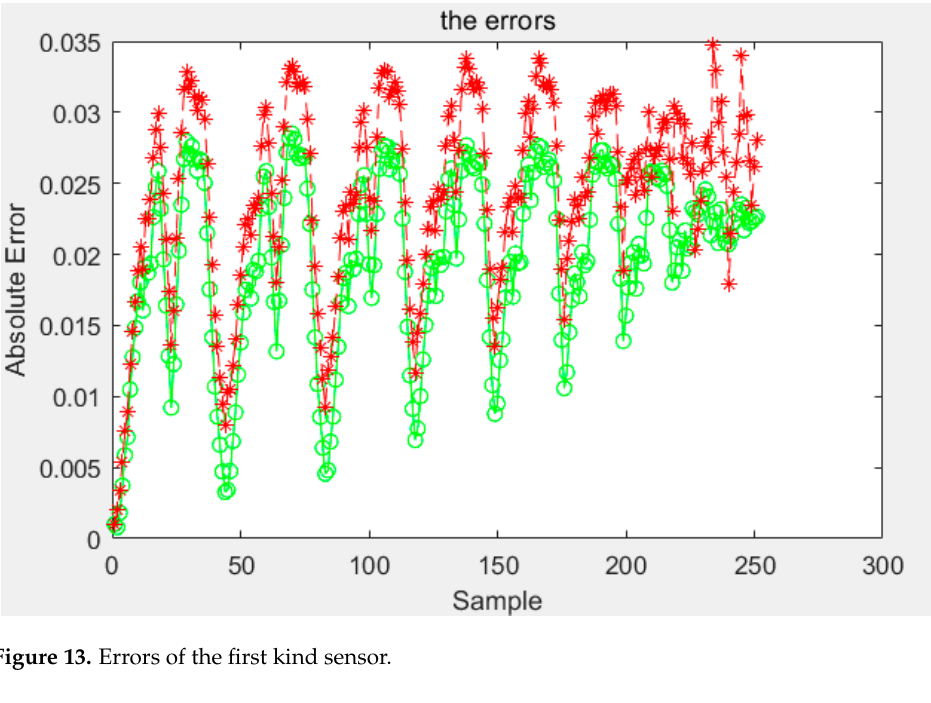
Figure 12. Test results of the first kind sensor.